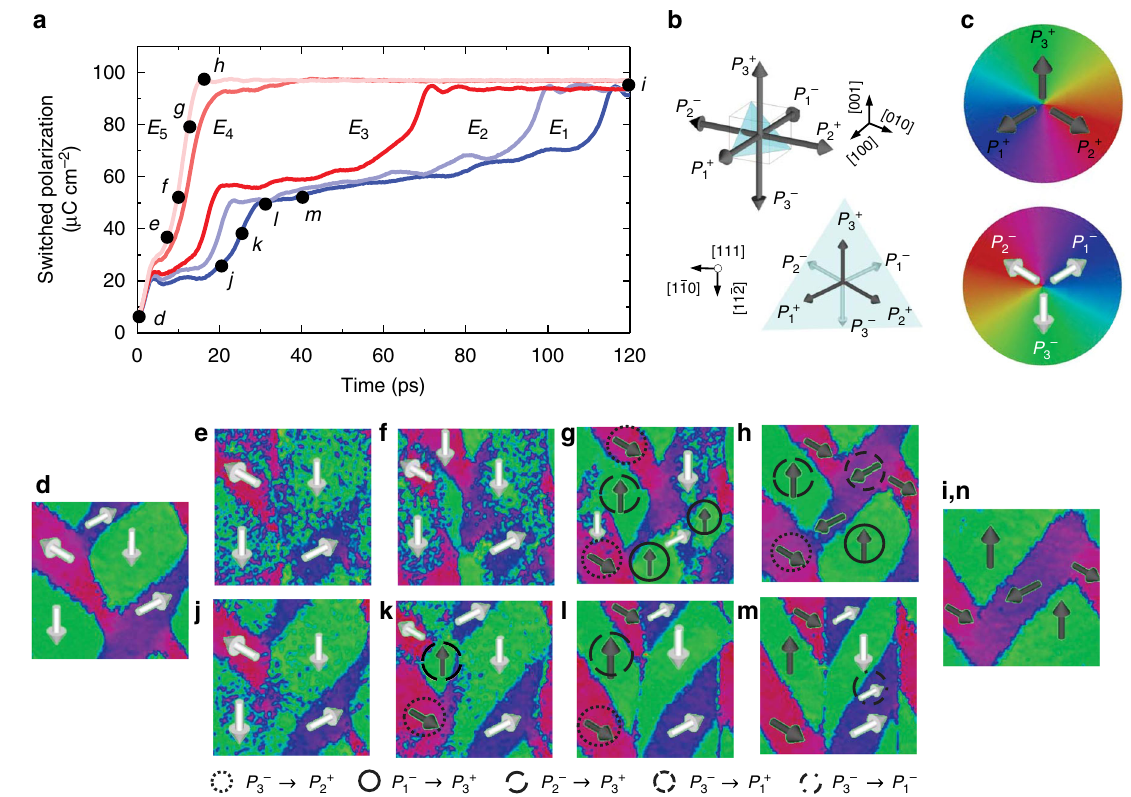
Fig. 3 Molecular-dynamics simulations. a Evolution of switched polarization in response to electric fi eld applied along the [111] for different fi eld magnitudes ( E 1 < E 2 < E 3 < E 4 < E 5 ). b Schematics of the six possible polarization variants in (111)-oriented tetragonal ferroelectrics and their corresponding projections on the (111). To guide the visualization, the polarization vectors with positive [111] components are colored in black and those with negative [111] components are colored in white. c Spherical coordinate-based color scheme used to represent the up-poled polarization variants (top panel) and the down-poled polarization variants (bottom panel). Simulated domain evolution under ( d – i ), high ( E = E 5 ) and ( d , j – n ), low ( E = E 1 ) fi elds revealing two distinct switching pathways. Under low fi elds, the domains experience substantial changes in the twinning structures, characterized by an intermediate state with partially-switched polarization ( k – m ). Under high fi elds, three coordinated 90° switching events g , enable rapid ferroelectric switching